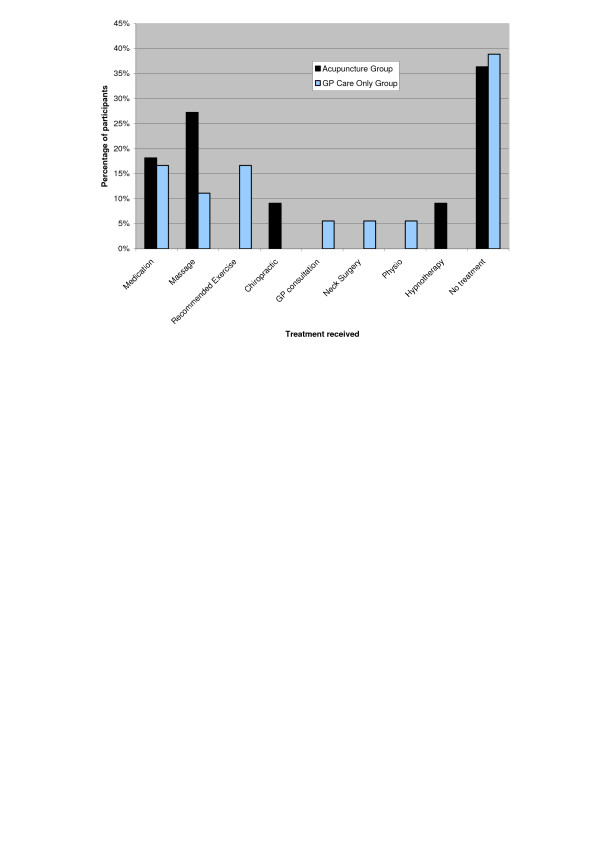
Usual care treatments received at three months as reported by both groups of patients.